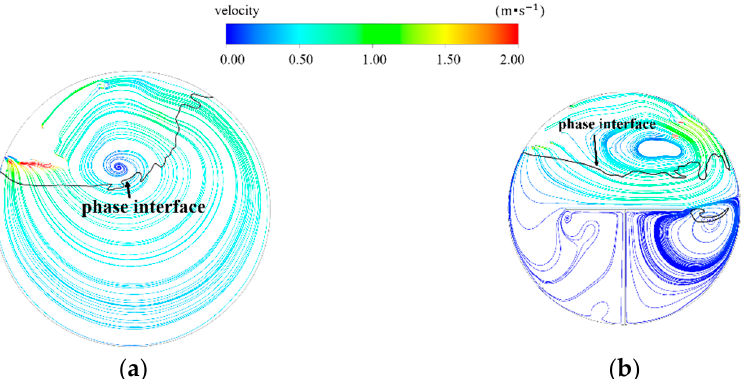
Figure 15. Flow diagram with T-shaped baffle vs. non-baffle (LR = 70%, t = 1 s). ( a ) non-baffle; ( b ) baffle with HR = 0.5.